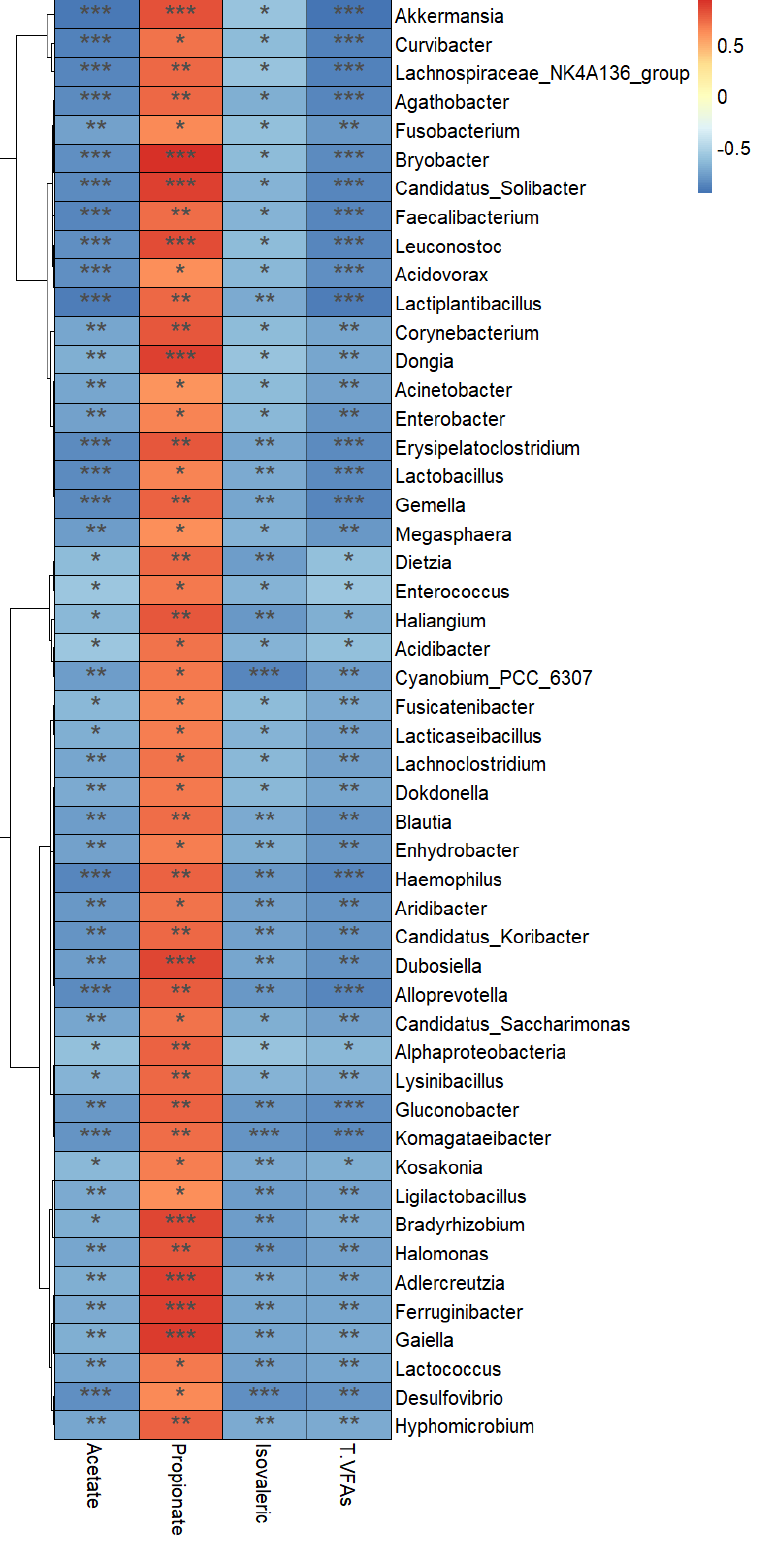
Figure 9. Correlation heatmap between changed fecal microbiota and altered short-chain fatty acids in Eurasian otters and golden snub-nosed monkeys. The correlation coefficients with a statistical p value <0.05 and an absolute value >0.7 were used to construct the network graph. * p < 0.05, ** p < 0.01, *** p < 0.001.